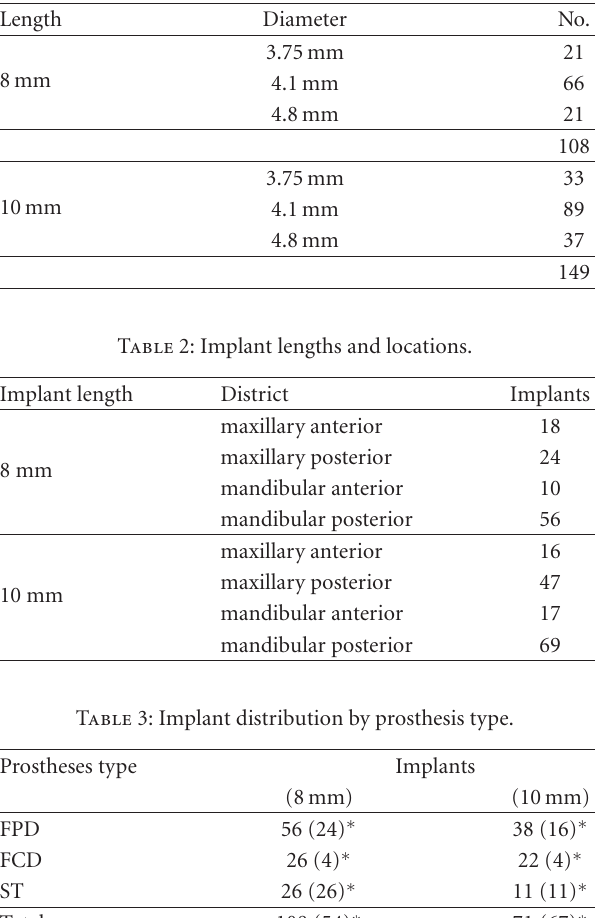
Table 1: Implant distribution by diameter, length, and type.